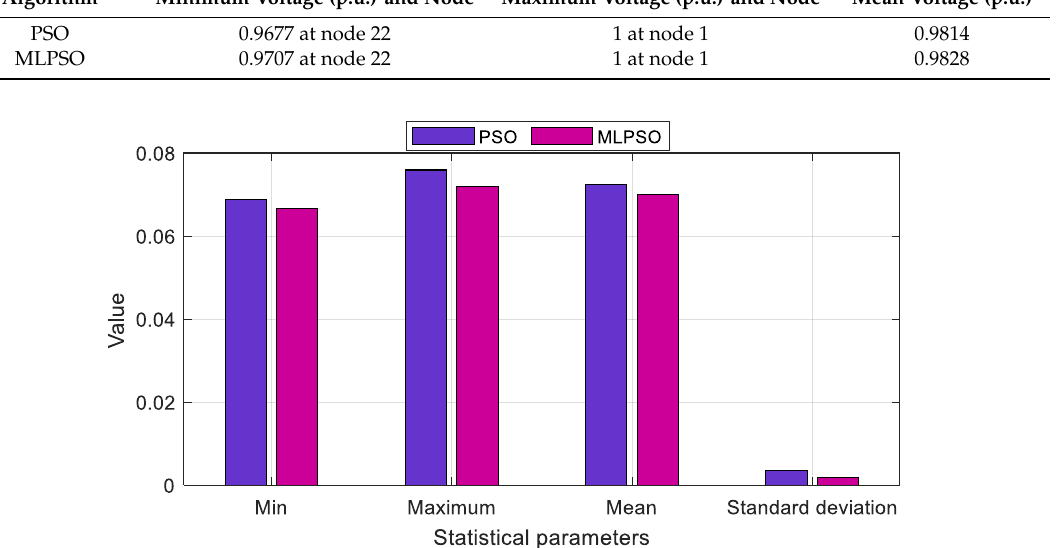
Figure 12. Variation of statistical parameters of PSO variants for the Malaysian bus system.